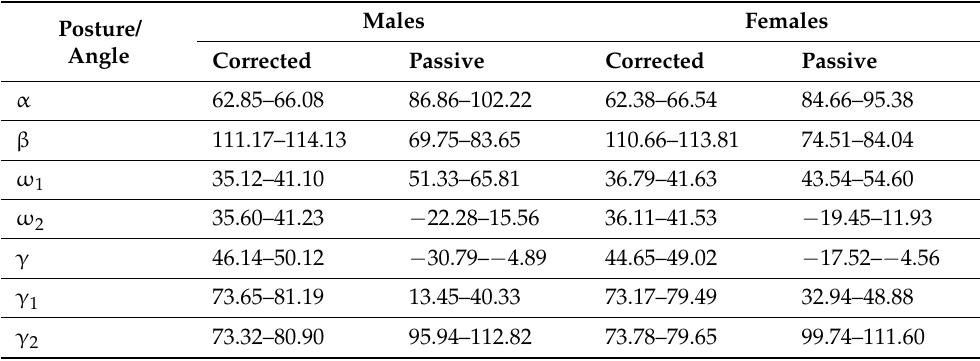
Table 6. Confidence intervals for angles